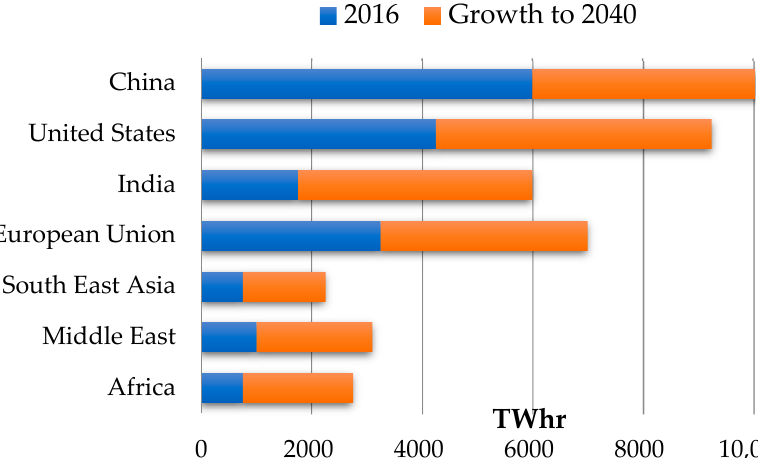
Figure 1. Electricity generation by selected region up to 2040. Source: International Energy Agency [3].